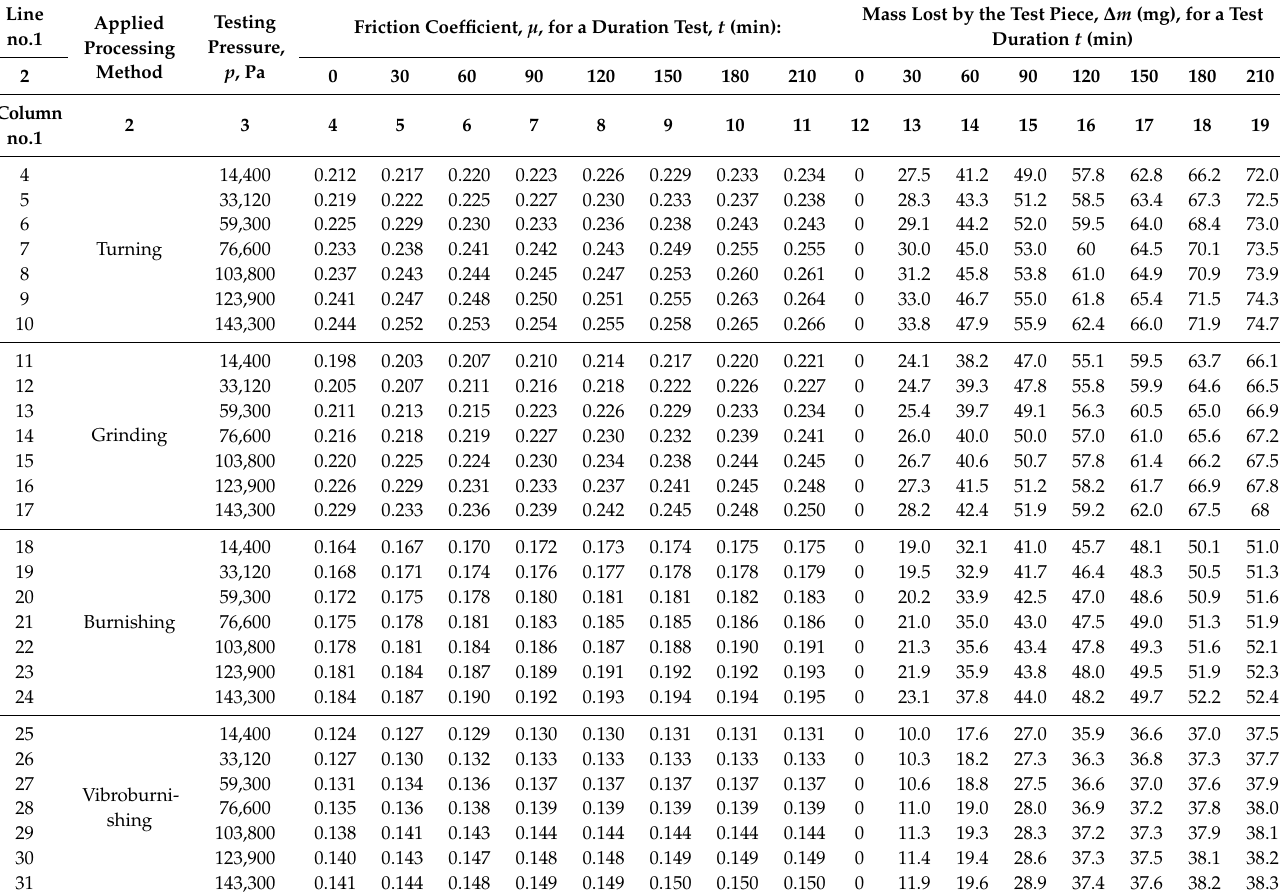
Table 1. Experimental conditions and